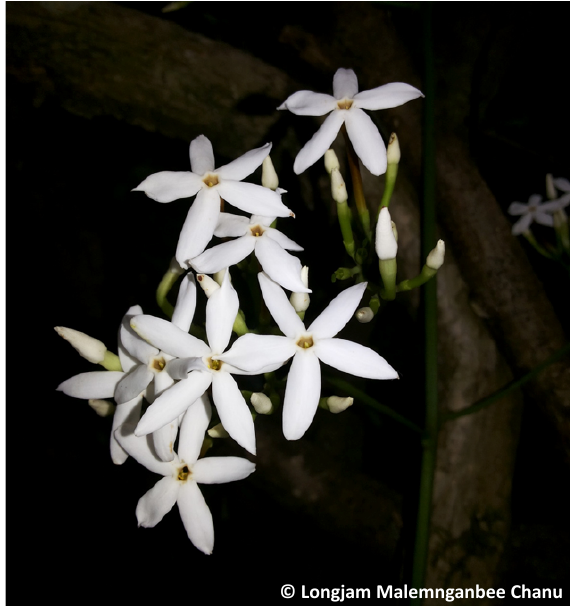
Image 3. Jasminum lanceolaria